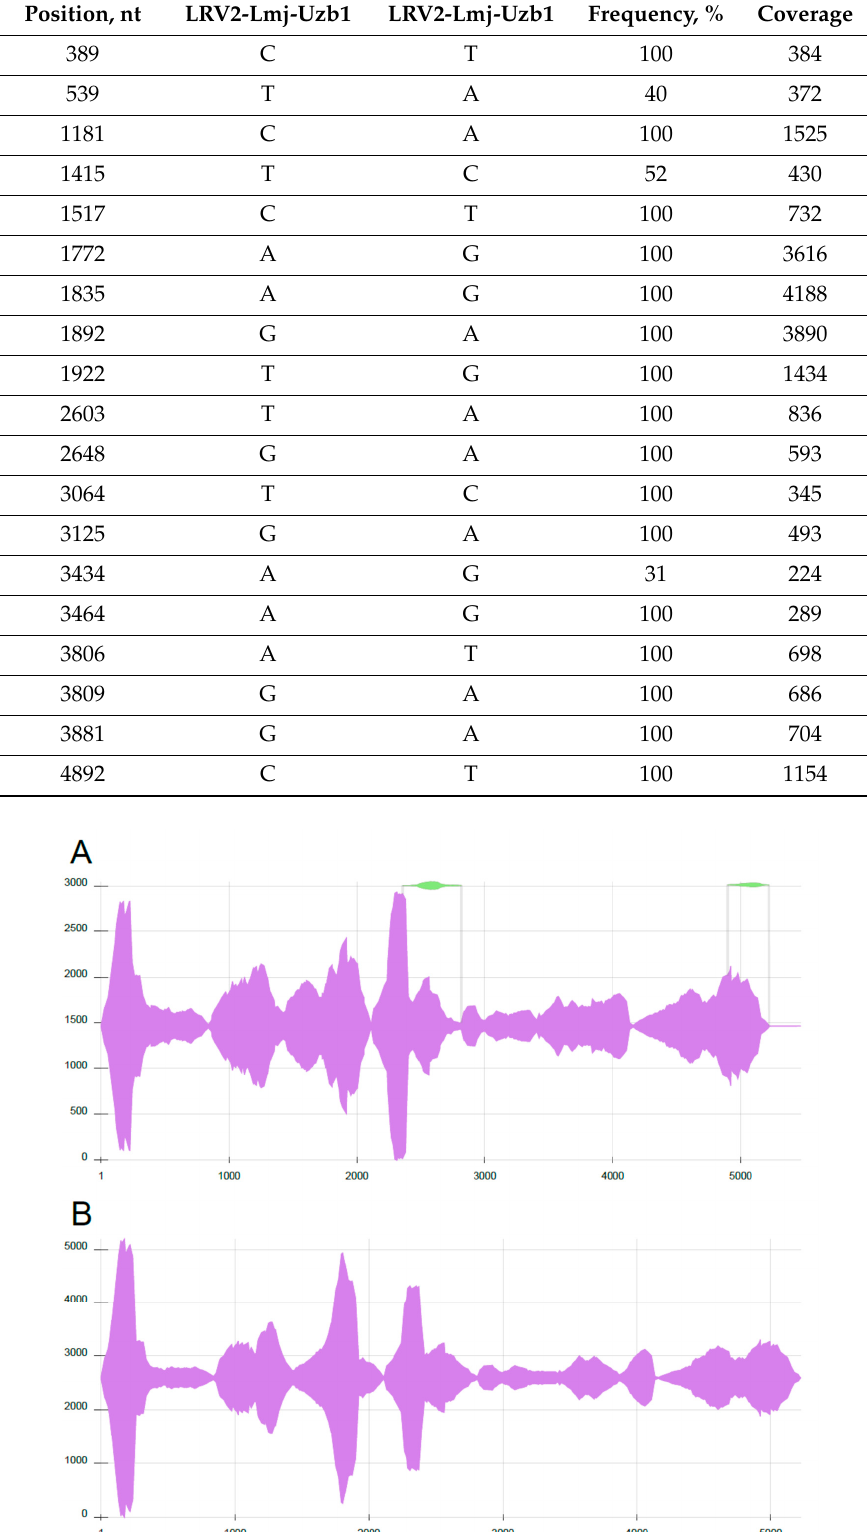
Table 2. SNP comparison between LRV2-Lmj-Uzb1 and LRV2-Lmj-Uzb2. Coverage indicates a total number of sequence reads covering each position on the genome.